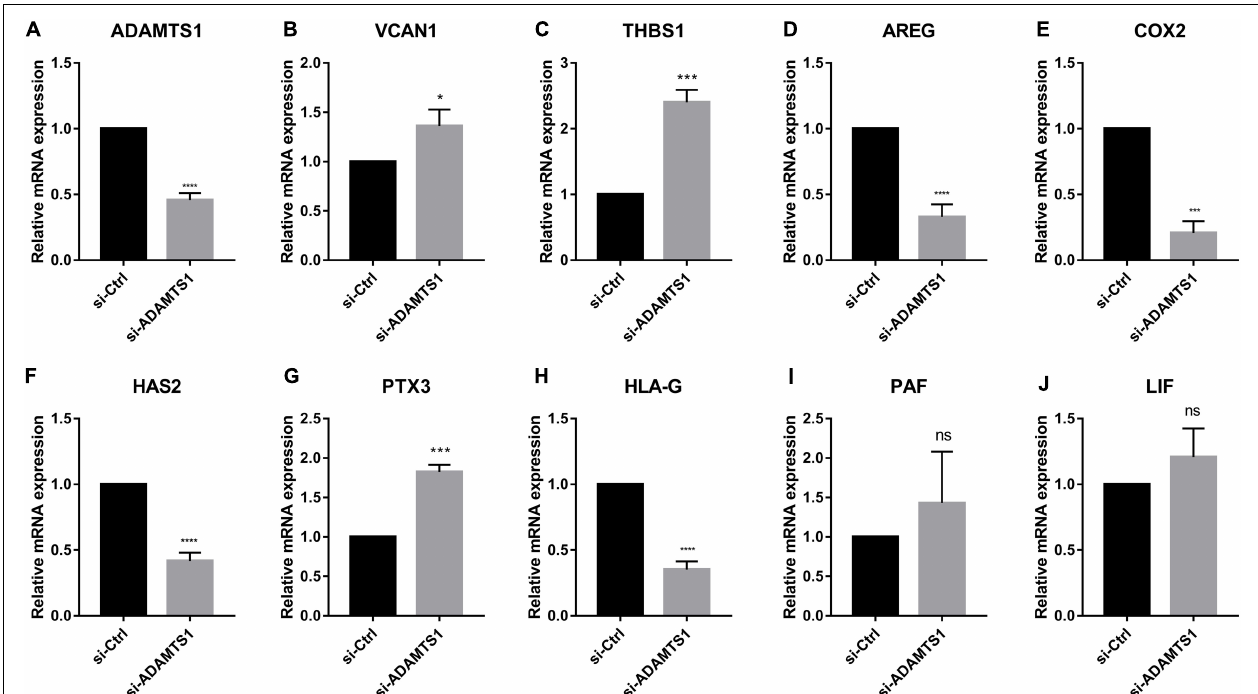
FIGURE 5 | Embryonic development related genes can be regulated after silencing of ADAMTS1 (A) in granulosa cells. The relative expression of VCAN1 (B) , THBS1 (C) , AREG (D) , COX2 (E) , HAS2 (F) , PTX3 (G) , HLA-G (H) , PAF (I) , and LIF (J) in primary granulosa cells after silencing ADAMTS1 gene by 50 nM siRNA. GAPDH gene was used as an internal control. * Indicates p < 0.05, *** indicates p < 0.001, **** indicates p < 0.0001 and “ns” indicates no significant